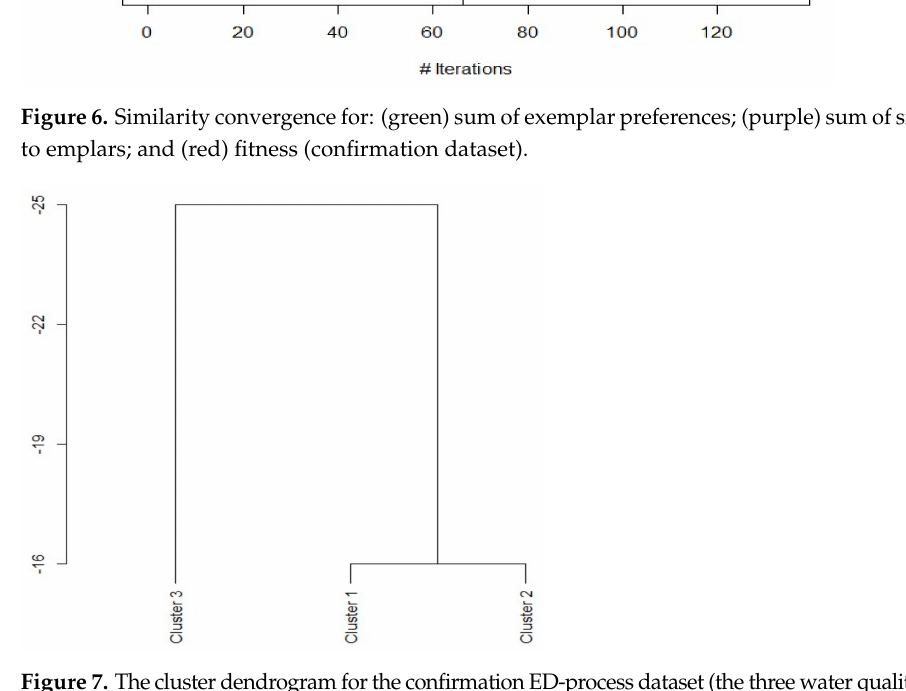
Figure 7. The cluster dendrogram for the confirmation ED-process dataset (the three water quality